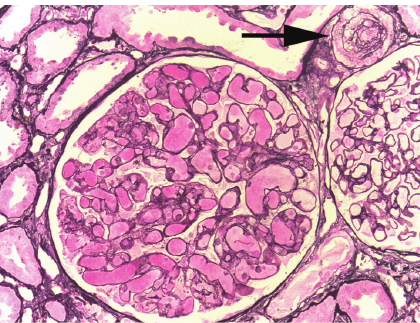
Figure 4: Renal biopsy. Renal biopsy showed 7 out of 36 obsolete glomeruli and 15% chronic tubulointerstitial damage. Note the capillary thrombus with intimal edema of the afferent arteriole (arrow).